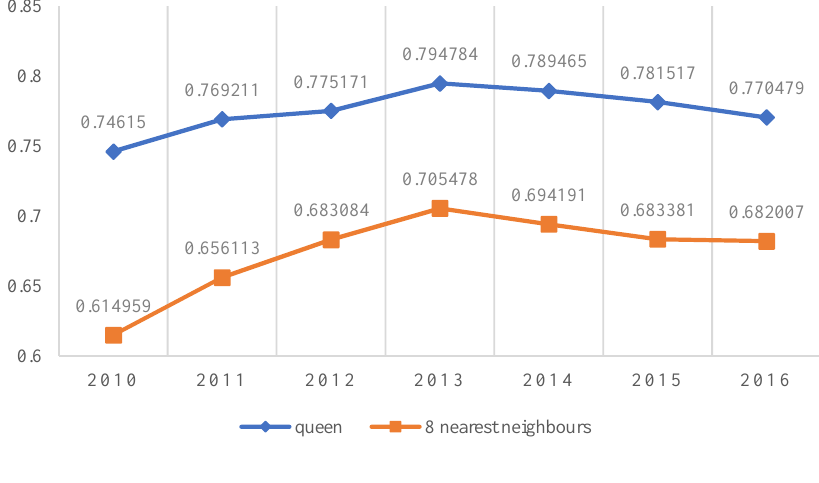
Figure 4. Moran’s I statistics of employment rates 2010–2016